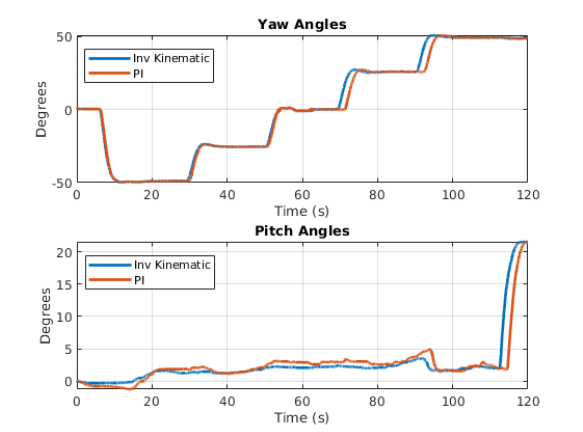
Figure 11. Angle comparation of controllers vertical serpentine trajectory with fixed distance.